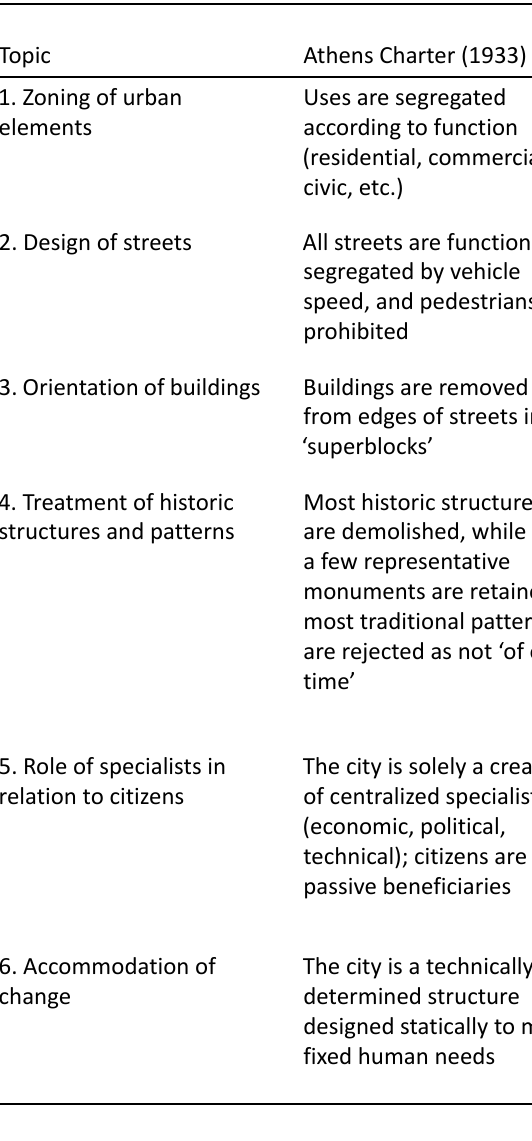
Table 1. Comparison of the three documents (Athens Charter, Charter of the New Urbanism, and New Urban Agenda) on six normative topics of